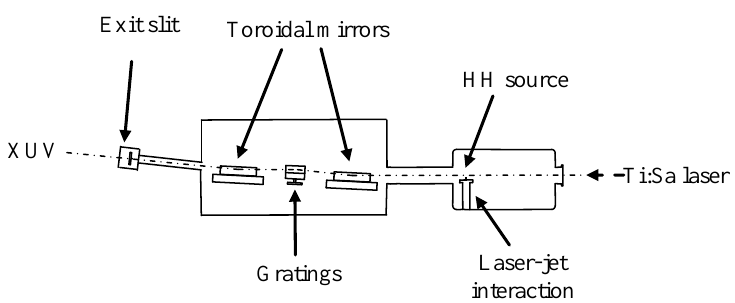
Figure 2. Schematic of the OPM